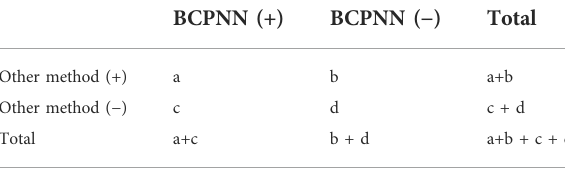
TABLE 2 Four-fold table for calculating sensitivity and speci fi city.